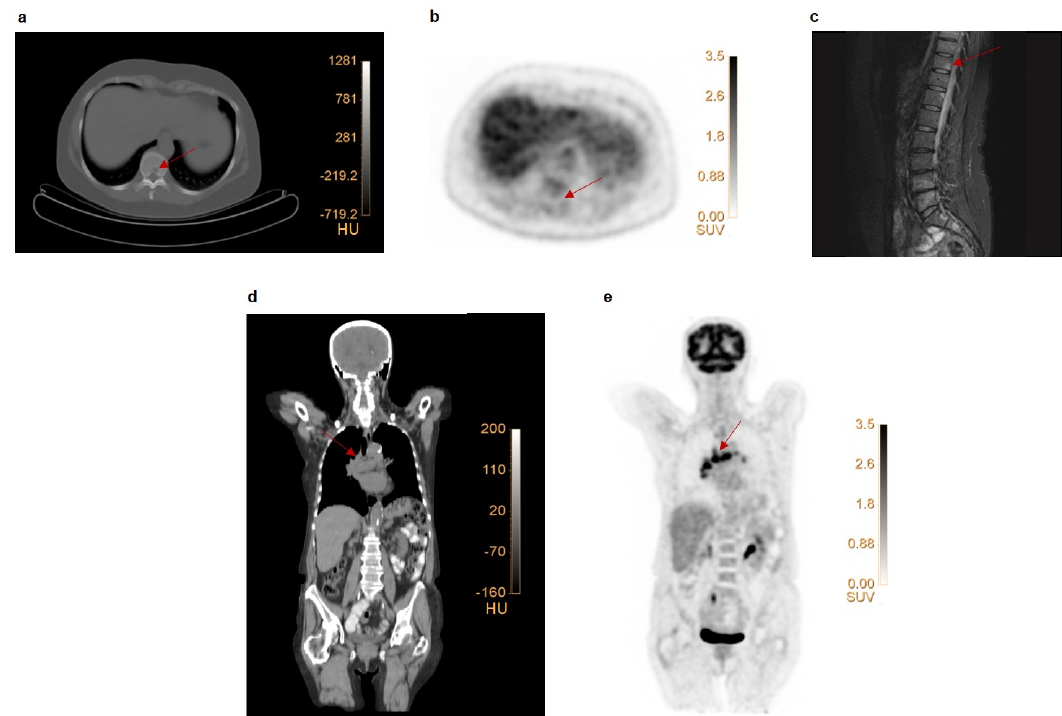
Figure 1. Examples of false negative and false positive lesions on FDG PET. ( a – c ) Patient with primary ER+ breast cancer with faint uptake in the primary tumor (SUV max 2.3). Low-dose CT ( a ) revealed a lytic lesion in the 10 th thoracic vertebra (Th10) without enhanced FDG uptake ( b ). An MRI scan ( c ) revealed multiple vertebral metastases (Th4, Th11, Th12, L4, L5), including the one at Th10. This lesion was classified as false negative on FDG PET. ( d – e ) Patient with multiple mediastinal FDG avid, suspect lymph nodes. Coronal section of a low-dose CT-scan ( d ) and FDG PET scan ( e ). Endobronchial ultrasound–guided biopsy of 3 mediastinal lymph nodes showed reactive cells. These lesions were, therefore, classified as false positive on FDG PET.